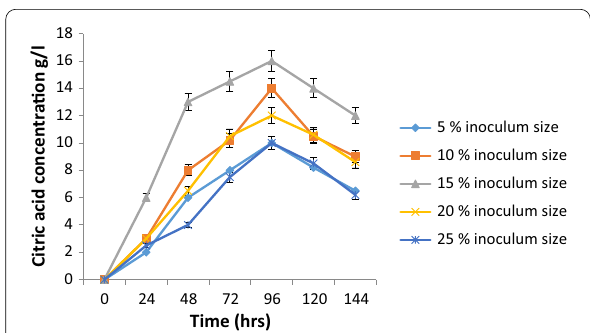
Fig. 1 Effect of wild cocoyam flour concentration on citric acid production